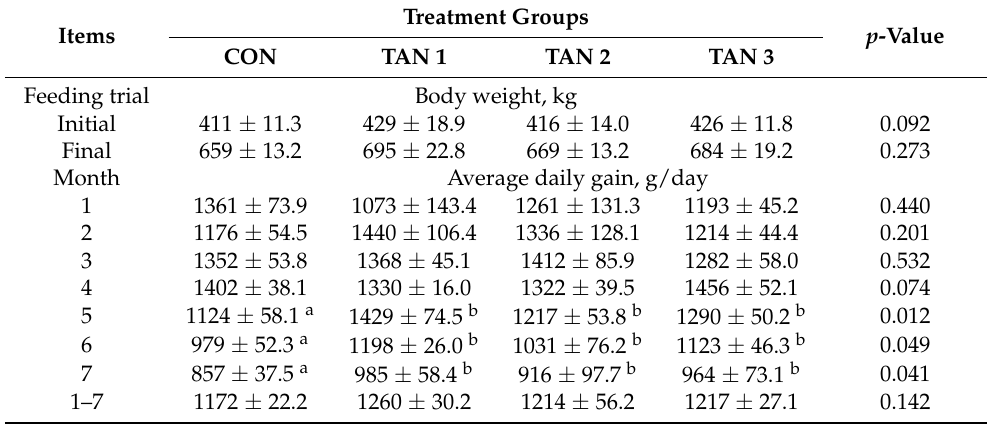
Table 3. Effect of supplemented hydrolyzable tannins on growth performance of Limousin